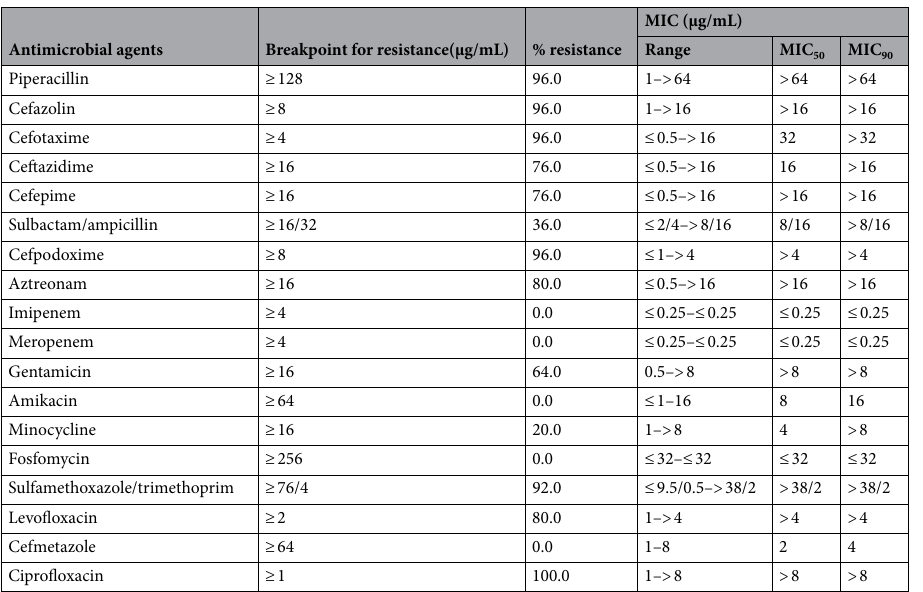
Table 2. Minimum Inhibitory Concentration 50 (MIC 50 ) and Minimum Inhibitory Concentration 90 (MIC 90 ) values and antibiotics resistance percentage values among twenty-five (25) ST131 E. coli isolates.